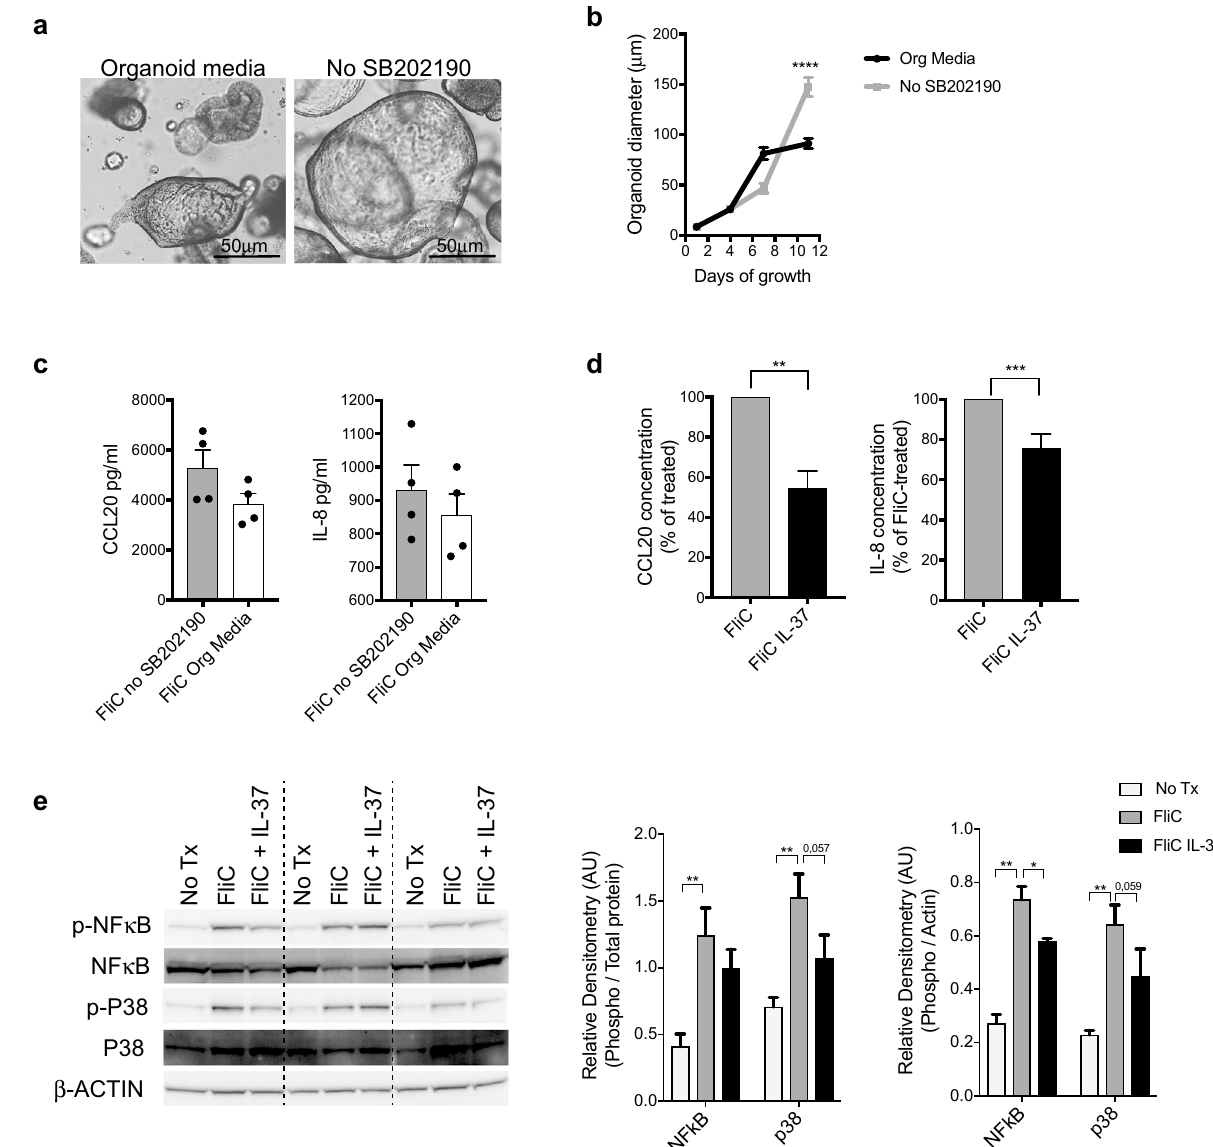
Figure 3. SB202190 effect on IL37 immunosuppressive responses. ( a ) Brightfield images of a representative human colonoids grown in standard organoid Media (left) or in No SB202190 media (right). b ) Growth curve of colonoids grown in standard organoid media or in No SB202190 media for 12 days. ( c ) IL-8 and CCL20 protein levels secreted basolaterally after 4 h of stimulation with FliC of human colonoids grown in standard organoids media or in No SB202190 media. ( d ) IL-8 and CCL20 protein levels secreted basolaterally by human colonoids grown in No SB202190 media after 4 h of stimulation simultaneously with FliC and IL-37. ( e ) Western blot analysis of phospho and total NFkB, phospho and total p38 in human colonoids grown in No SB202 media after 30 min of stimulation with FliC with or without IL-37 (left). Equal loading confirmed with β-Actin as well as total protein stain of membrane (see Fig. S5 online). Densities relative to total protein or β-Actin are shown (right). Mean and SEM are indicated from n = 4 donors (2 adult and 2 pediatric). All data shown are representative of at least 3 independent experiments. Statistical significance calculated using unpaired Student’s t -test *, P = 0.01 to 0.05; **, P = 0.001 to 0.01; ***, P = 0.0001 to 0.001; ****, P = 0.00001 to 0.0001. Comparison lacking annotations are not